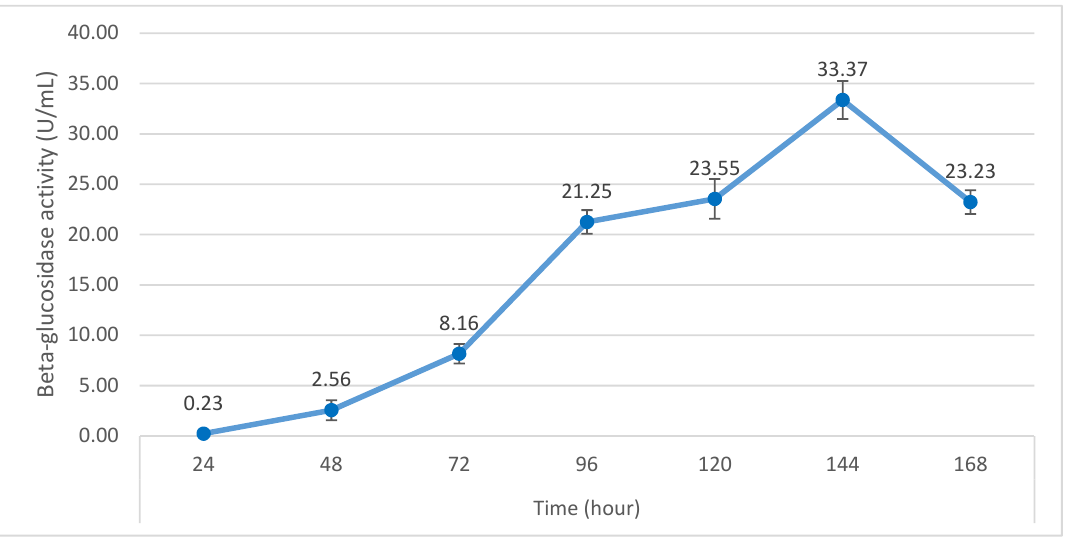
Figure 3. E ff ect of fermentation time on β -glucosidase activity of P. citrinum Figure 3. Effect of fermentation time on β -glucosidase activity of P. citrinum .